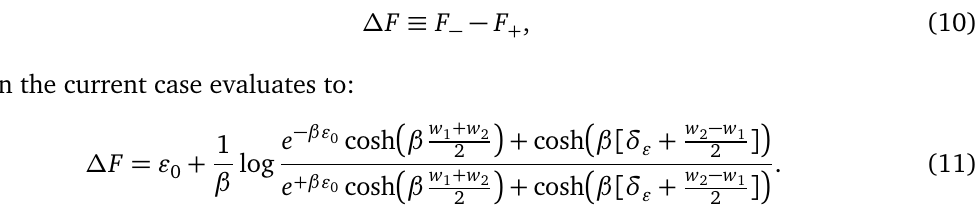
Figure 1: Occupancy configurations, labeled by n ± in columns, of the six-level system in the (a) even ( P = + 1) and (b) odd ( P = − 1) parity sector. The single-particle energy levels in the particle-hole symmetric BdG spectrum are denoted by ± (cid:34) This depicts a low energy model for a system with finite distance between the two vortices as investigated numerically in Sec.